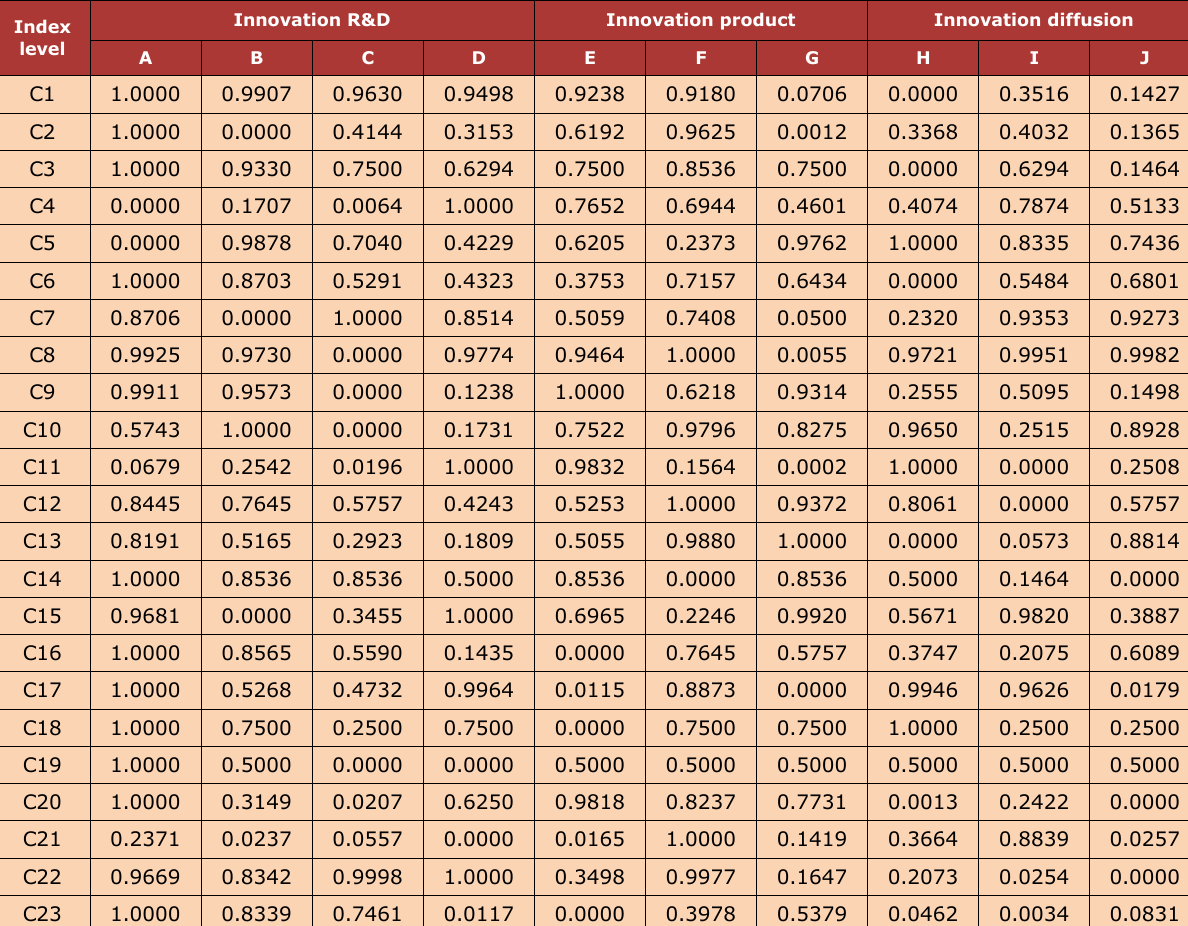
Table 6. Dimensionless Results of Innovation Chain Supplier